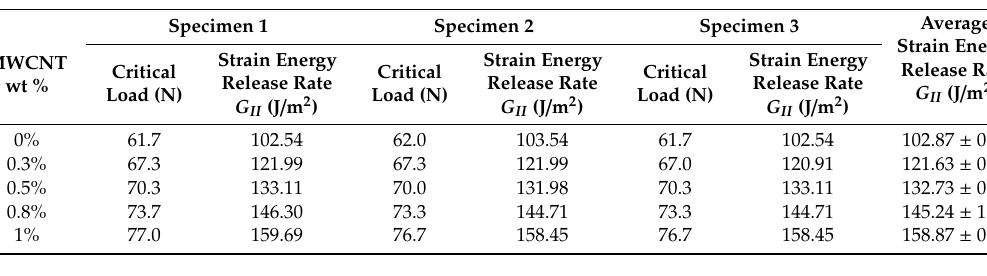
Table 1. Mode II strain energy release rate of the nanocomposite film/Al substrate composite structure with different MWCNT loadings.